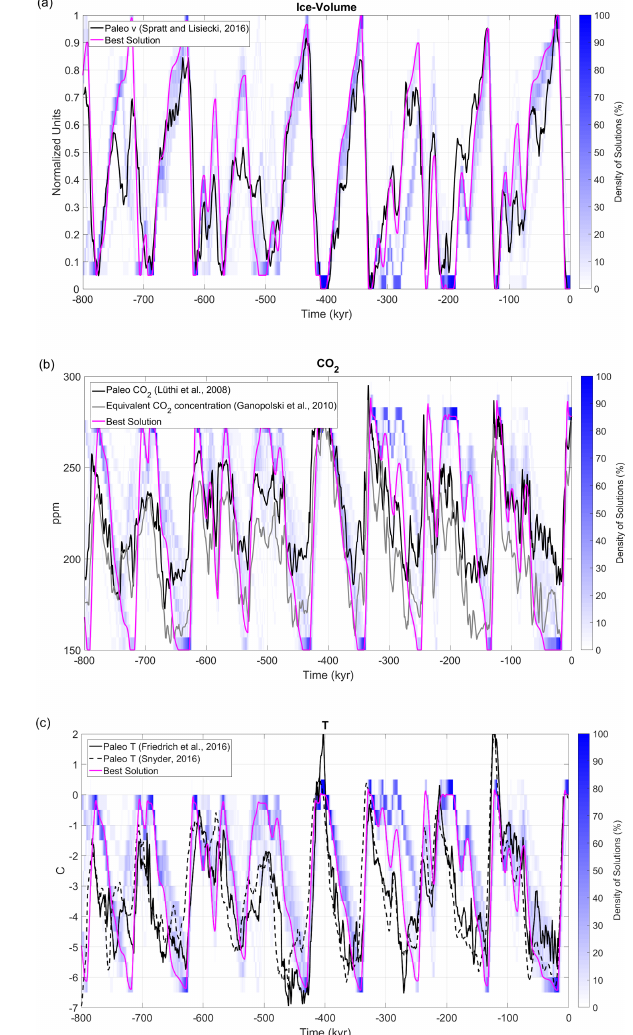
Figure 4. Same as Fig. 1 but for solutions in the Accepted ensem- ble. In addition, magenta lines show the evolution of the Best Solu- tion.